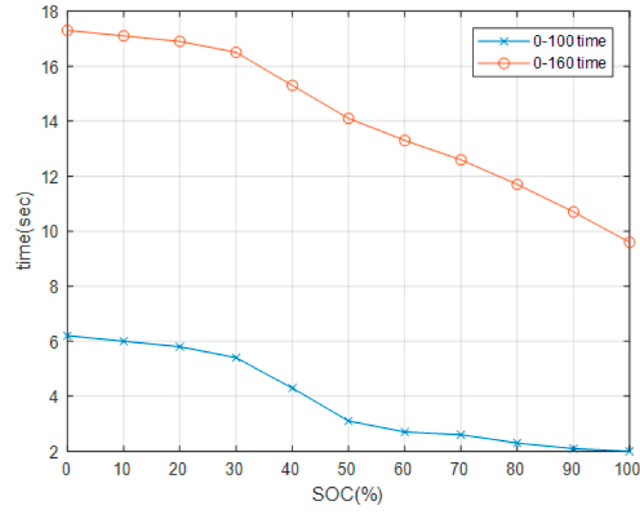
Figure 17. The 0–100 km/h time and 0–160 km/h time result versus initial SOC.